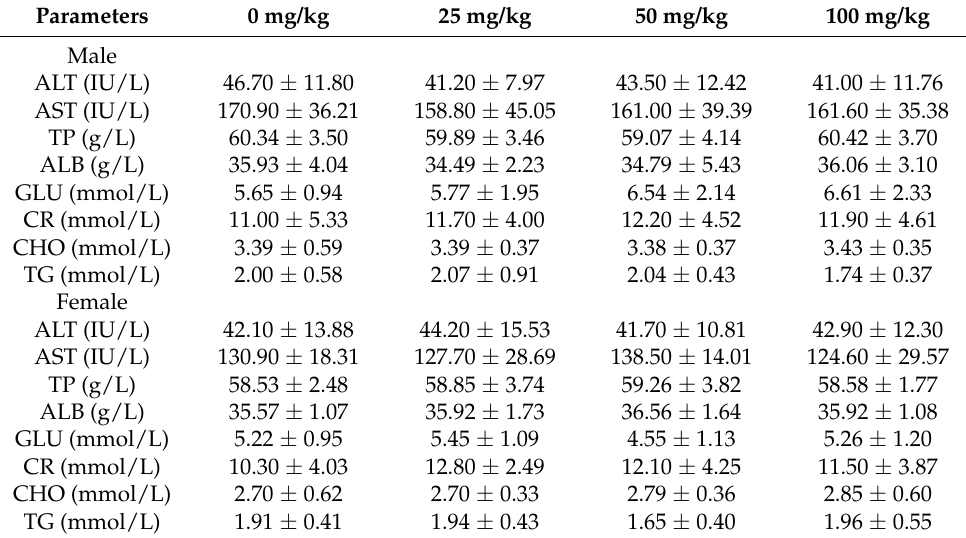
Table 8. Serum biochemical parameters in the repeated-dose 30-day oral toxicity study.